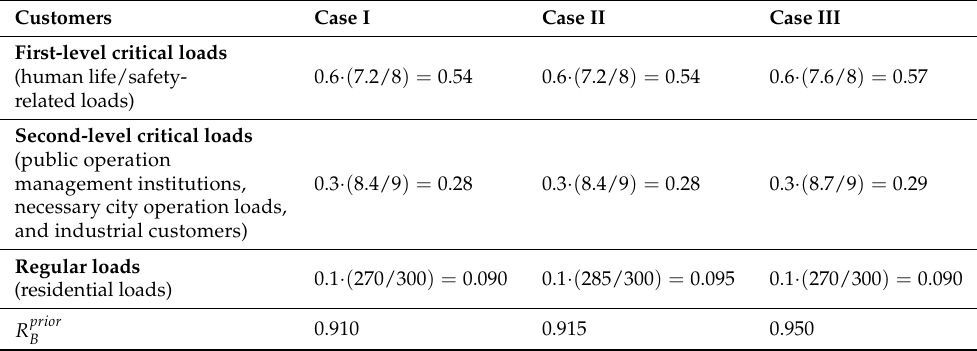
Table 3. Value of the resilience metric for different cases using